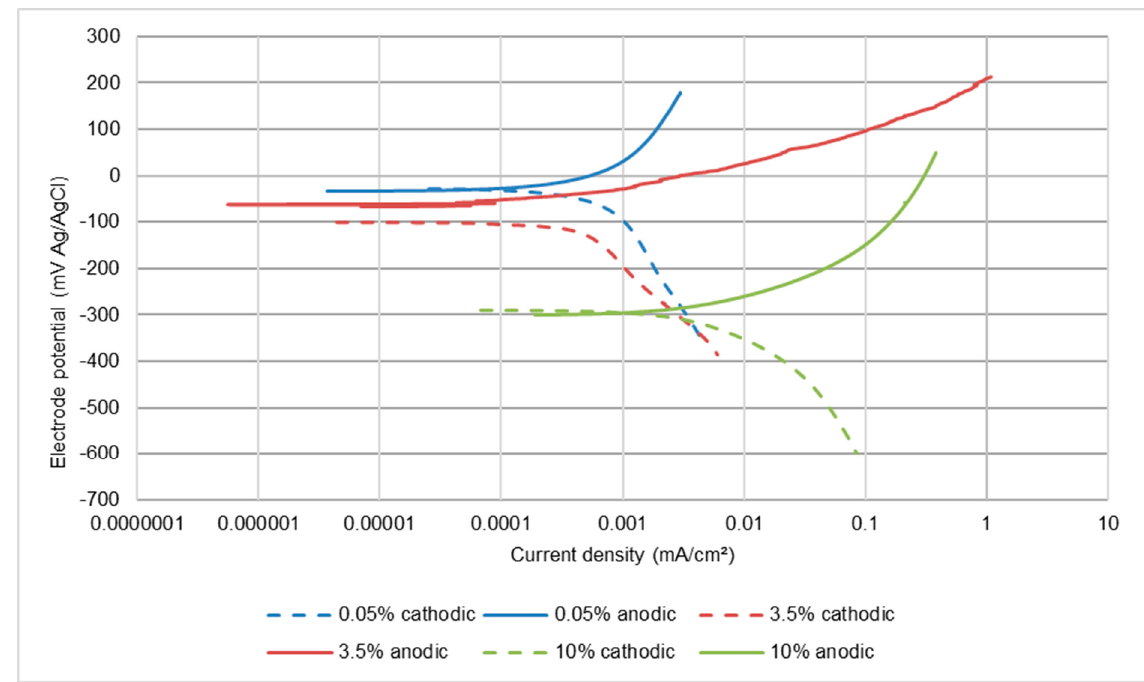
Figure 6. Polarisation plots for UNS S31600 in liquid impingement (LEC). Table 3. Influence of salinity on corrosion rates of UNS S31600 steel in the different hydrodynamic conditions.